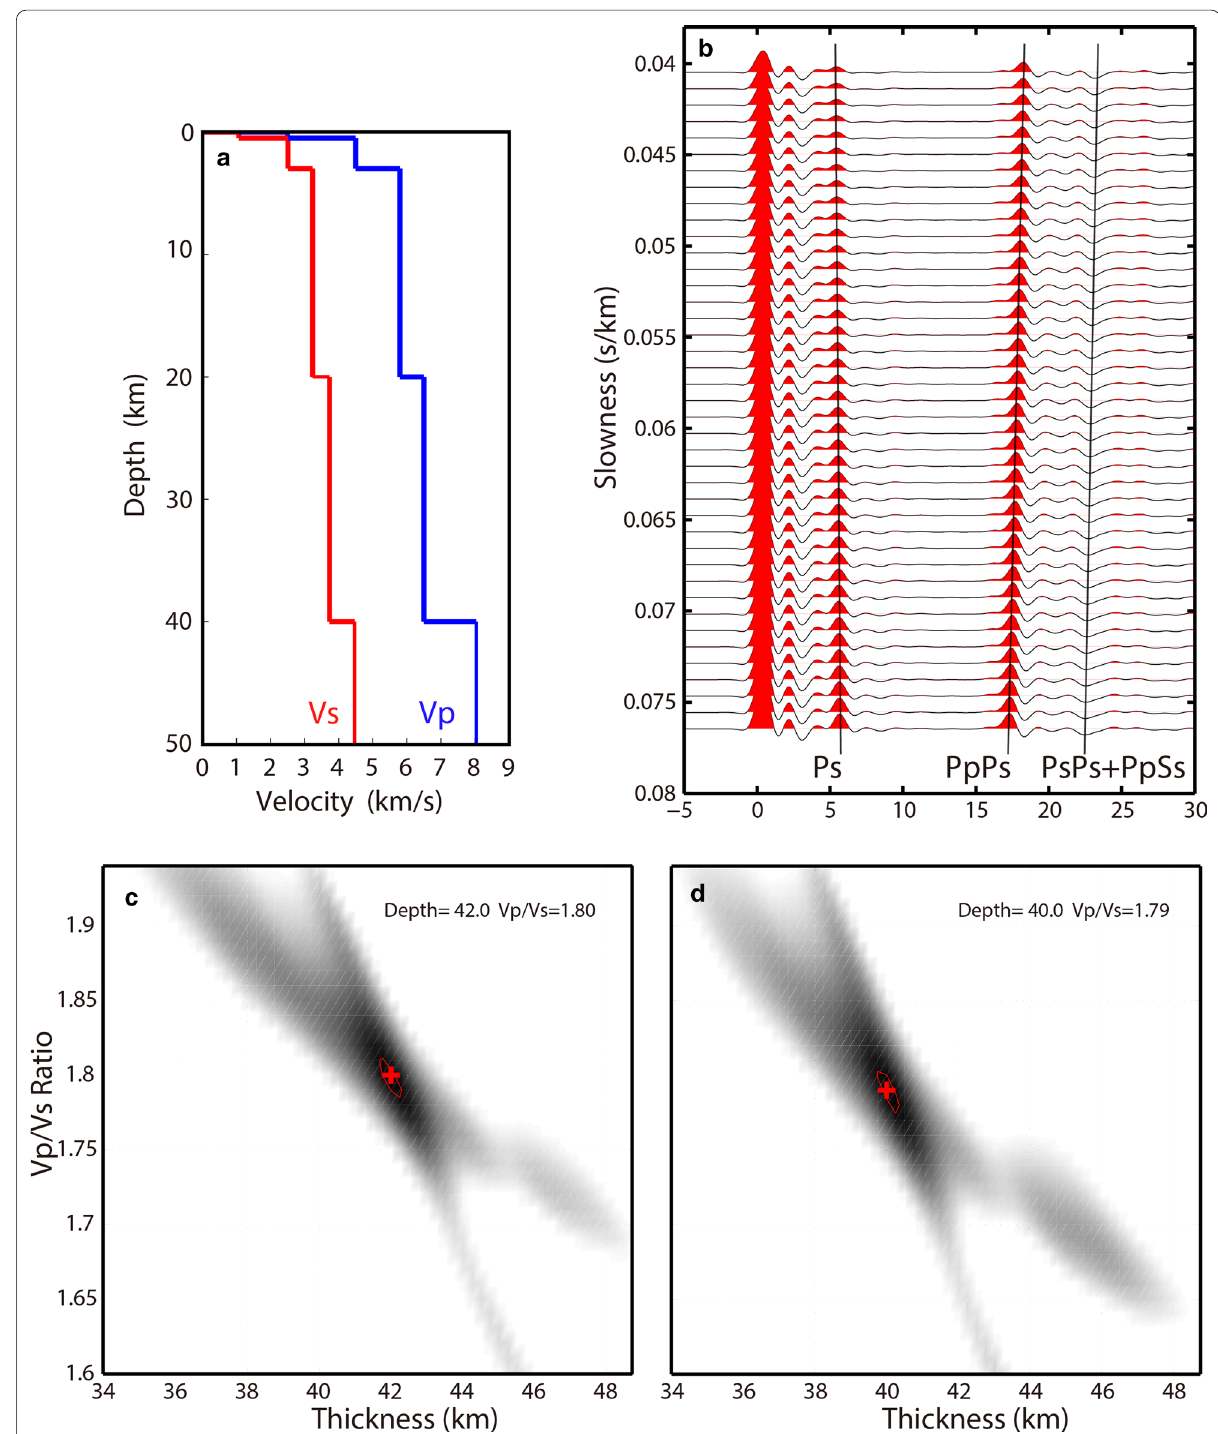
Fig. 3 Synthetic receiver function and test. a Velocity model. b Synthetic receiver function. c H - κ stacking without sediments. d H - κ stacking